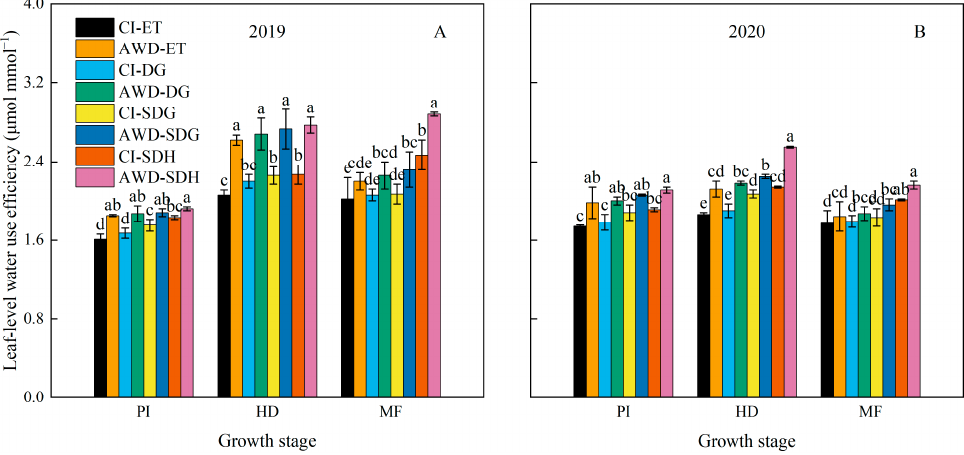
Figure 2. Leaf-level water use efficiency ( A , B ) at three growth stages of mid-season indica rice genotypes under different irrigation treatments. CI and AWD represent conventional irrigation treatment and alternate wetting and drying irrigation treatments, respectively. ET denotes early tall genotype, DG denotes dwarf genotype, SDG denotes semi-dwarf genotype, and SDH denotes semi-dwarf hybrid. PI, HD, and MF represent panicle initiation, heading, and middle grain filling stage, respectively. Vertical bars represent ± standard error of the mean where these exceed the size of the symbol. Different letters above the columns indicate significant differences ( p ≤ 0.05) within the same measurement time.